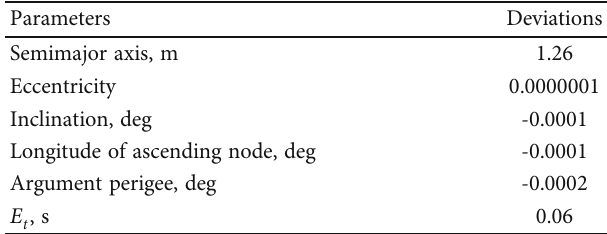
Table 6: Deviations of terminal orbital